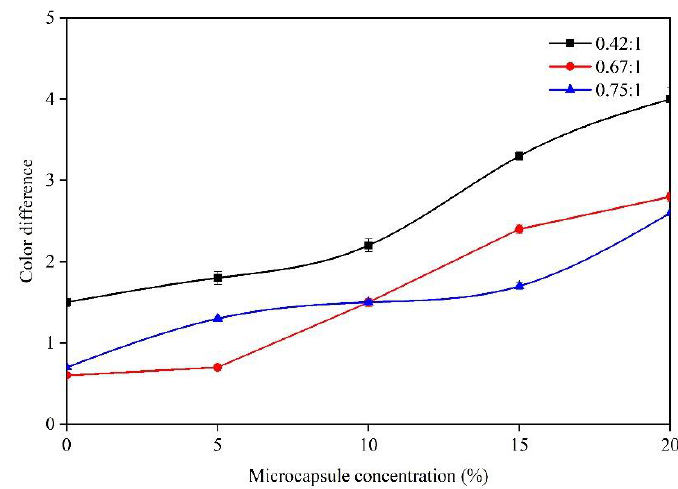
Figure 3. Effect of microcapsule concentration (0.42:1, 0.67:1, and 0.75:1 core-wall ratios) on color difference.